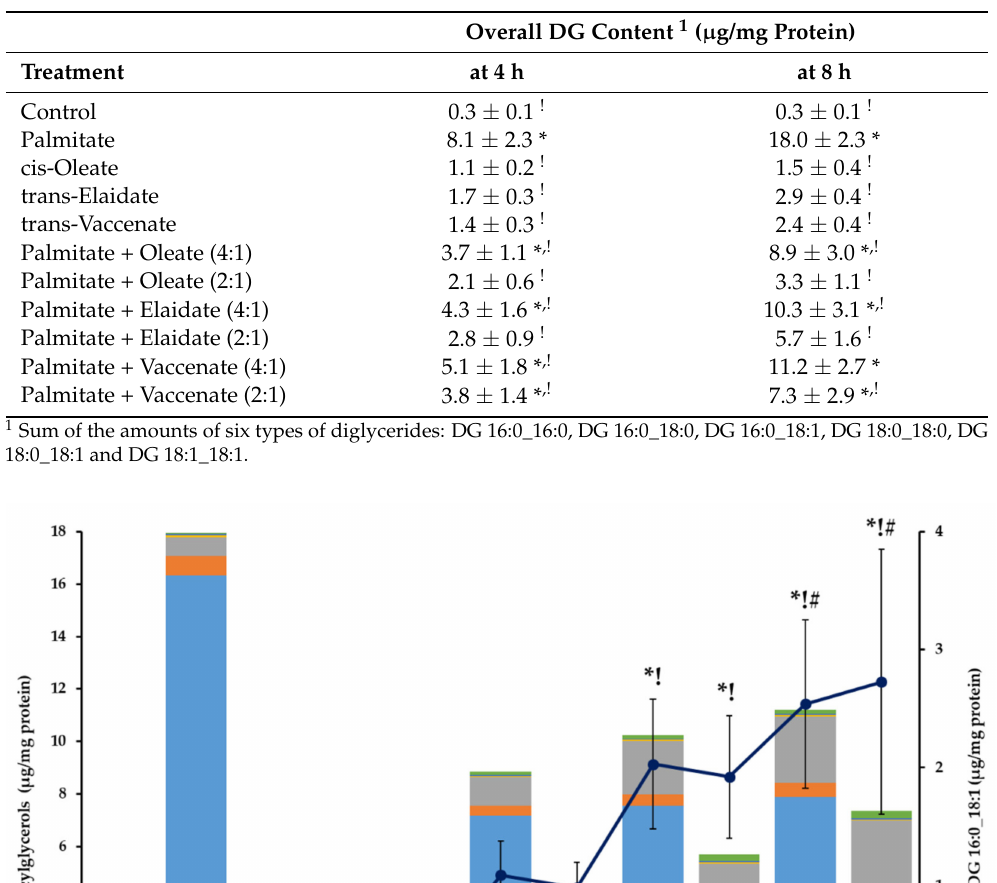
Table 3. Overall diglyceride content of hepatoma cells in lipotoxicity. Cells were treated with BSA- conjugated palmitate, oleate, elaidate or vaccenate (800 µ M) or with palmitate (800 µ M) and oleate, elaidate or vaccenate at a 4:1 or 2:1 molar ratio (200 or 400 µ M) at 70–80% confluence for 4 or 8 h. The overall amount of six relevant diglycerides was measured by LC-MS/MS. Data were normalized to the total protein content of the samples and are shown as mean values ± S.D.; n ≥ 4; statistically significant differences: * p < 0.05 vs. BSA treated control; ! p < 0.05 vs. palmitate treated samples.